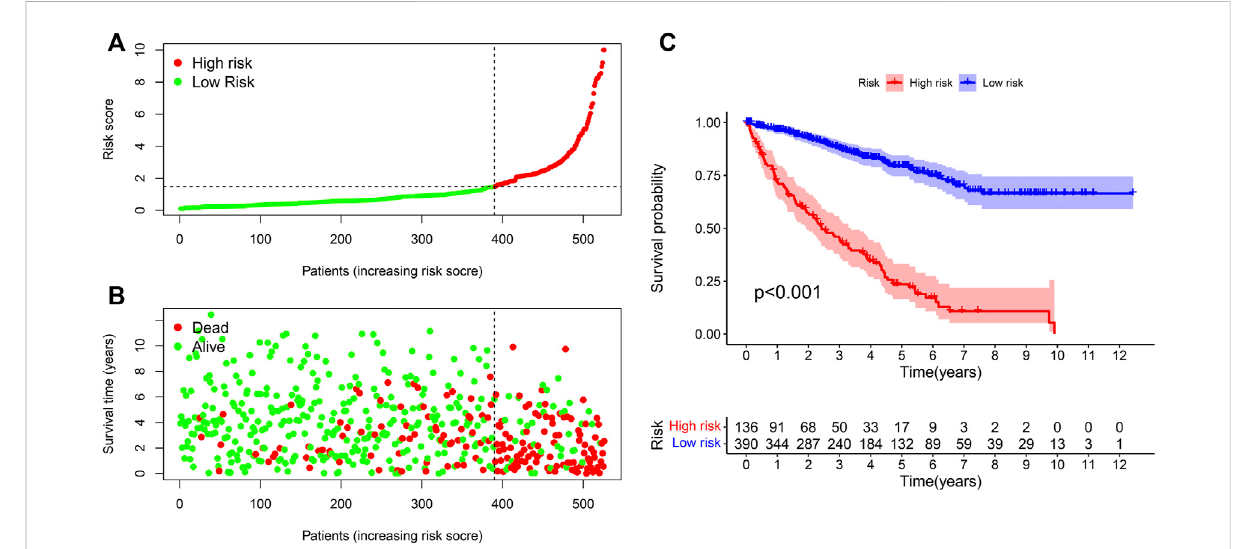
FIGURE 4 Correlation analysis of risk models and clinical indicators. (A) Computation of the risk score of every sufferer, so as to distinguish risk high and risk low sufferers as per the threshold. (B) Scatter plot of risk score and result for every sufferer. Red: high risk; Green: low risk. (C) K-M curve of OS between risk high and risk low